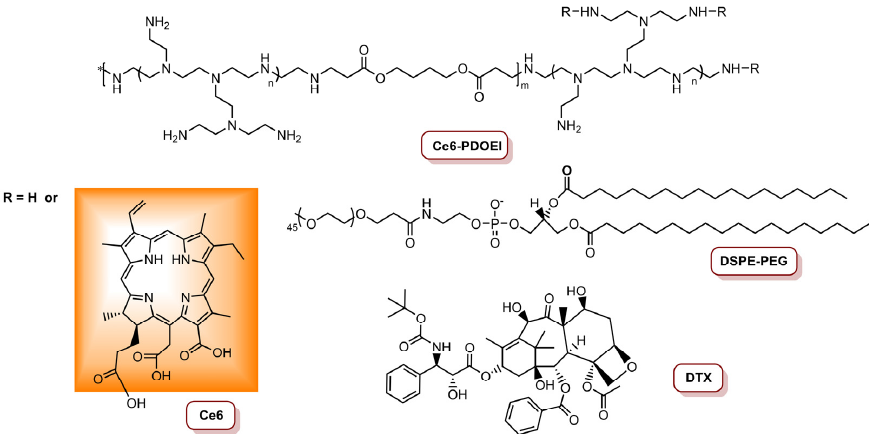
Figure 9. Representation of the structure of Ce 6 -PDOEI, DSPE-PEG and DTX involved in the preparation of CDTN.